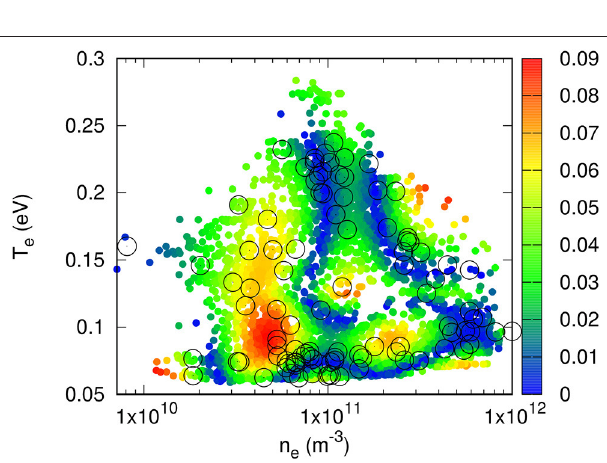
FIGURE 9 | Color plot of relative errors in model-inferred density in a validation data set consisting of approximately 5,000 randomly selected points. Circles show the positions of the 100 density and temperature pairs corresponding to the randomly selected